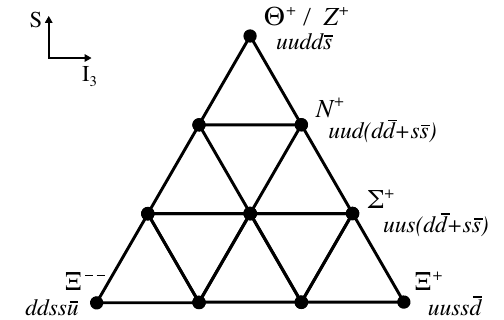
the LEPS results.